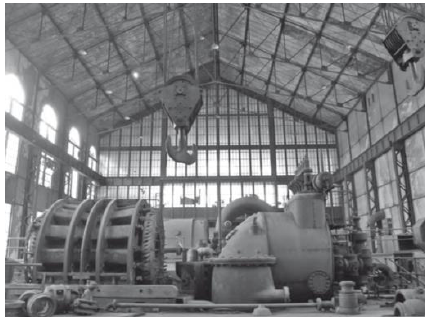
Figure 10. Silahtarağa Power Plant, the main machine